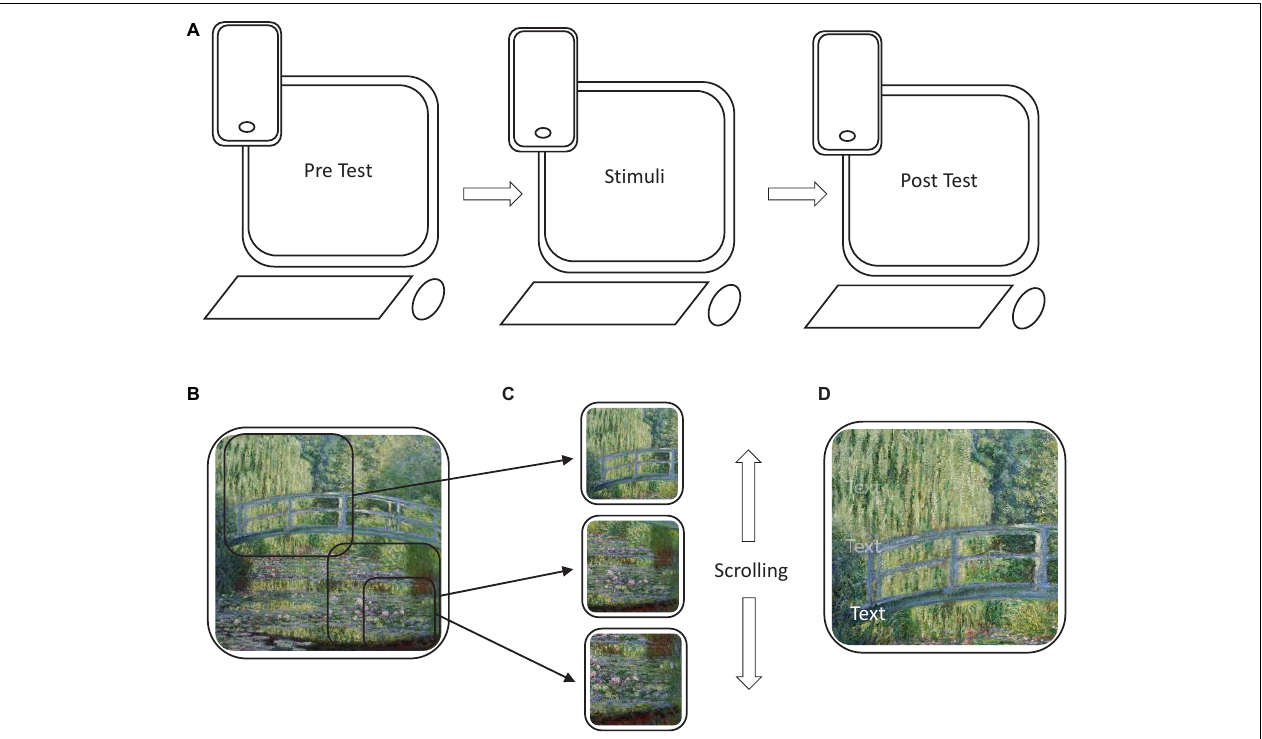
FIGURE 1 | Study design, stimuli composition. (A) The procedure was a pre-post design which could be taken on both personal computers and smartphones. (B) Demonstration of stimuli showing “Waterlilies condition” as an example depicting Claude Monet, The Water-Lily Pond, 1899. (Oil on canvas, 88.3 × 93.1 cm. public domain image, Wikimedia commons). Stimuli from Google Arts and Culture were interactive, where smaller compositions of one main image (B) could be scrolled through (C) with accompanying text that faded away when scrolling down (D) . Available from: https://commons.wikimedia.org/wiki/File:Water-Lilies-